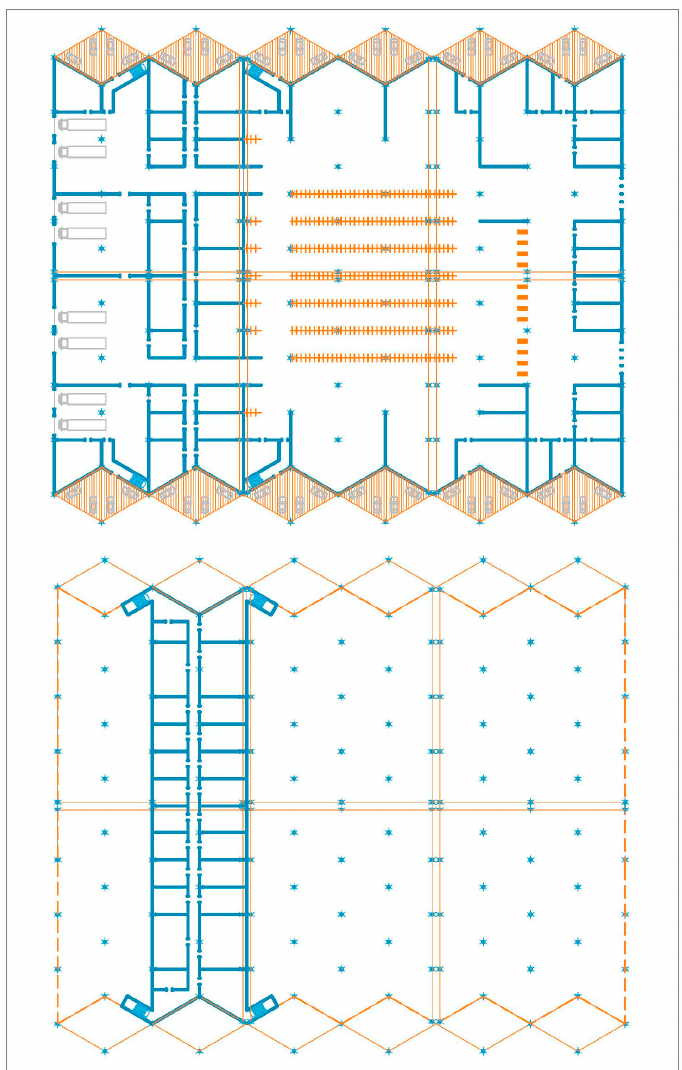
Figure 14. Planning solutions: the Supermarket—1st, 2nd floors.